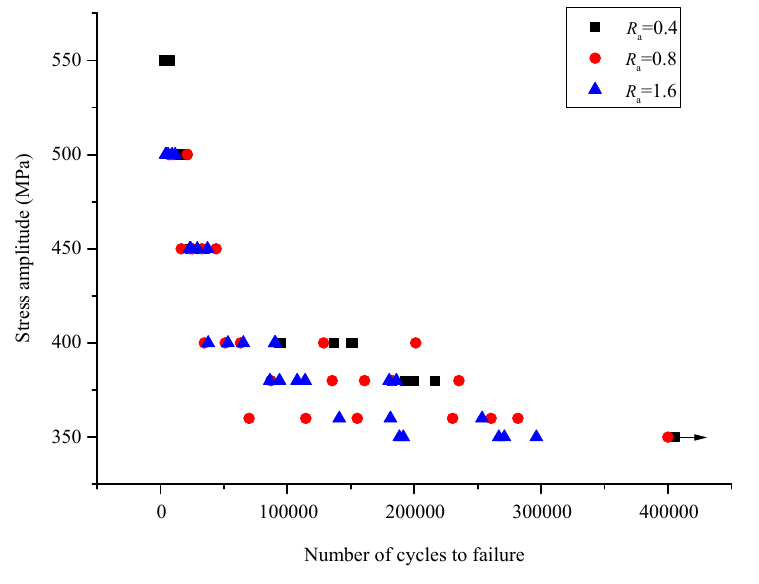
Figure 3. Scatterplot of the 75 fatigue tests.